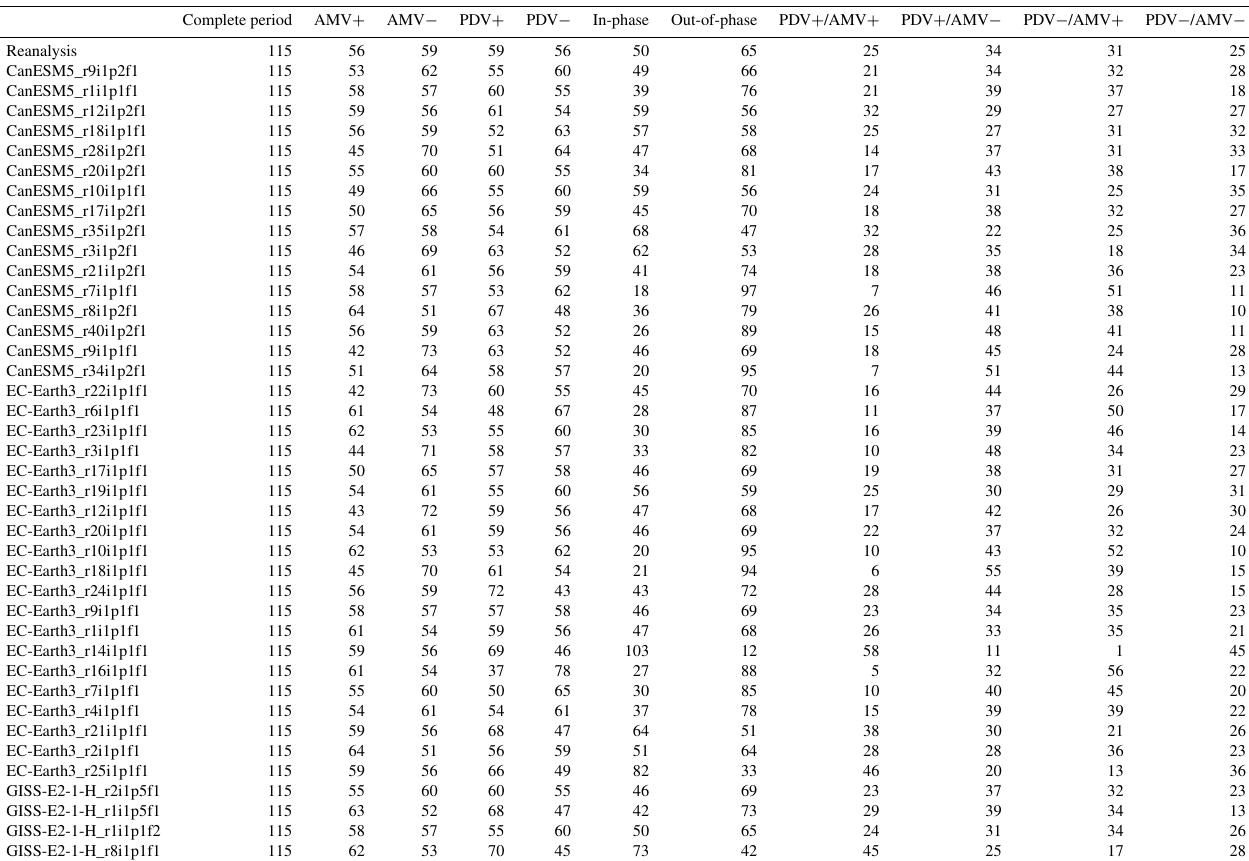
Table A6. Number of years for every regime for reanalysis and CMIP6 simulations